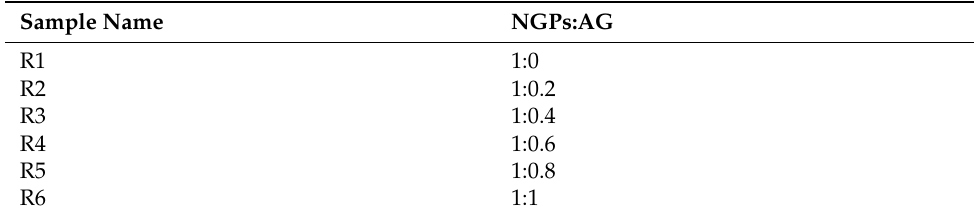
Table 4. Dispersion scheme mix